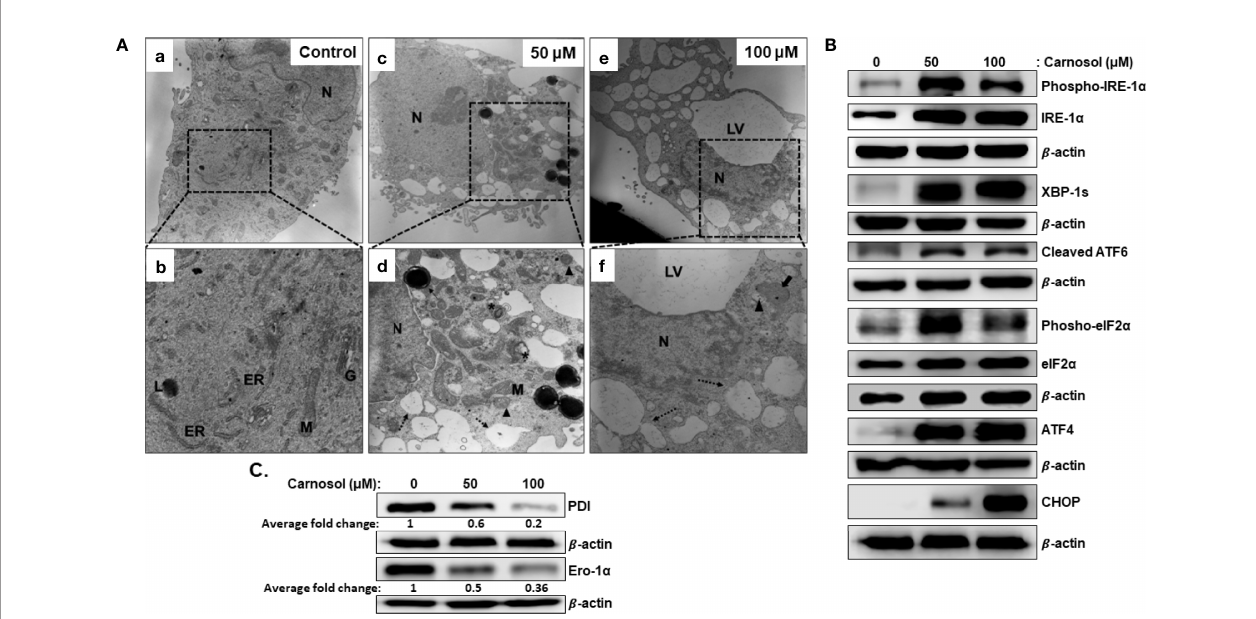
FIGURE 3 | Carnosol induces ER stress in MDA-MB-231 cells. (A) Representative electron micrographs of untreated MDA-MB-231 cells (a – b) and MDA-MB-231 cells treated with 50 (c – d) and 100 µM (e – f) carnosol for 24 h. (B) Activation of the UPR sensors in carnosol-treated cells. Cells were treated for 24 hours with carnosol (50 and 100 m M) and whole protein lysates were analyzed by Western blot for proteins of the ER stress markers. (C) Carnosol disrupts the proper protein folding machinery. Immunoblot of protein folding enzymes PDI and Ero-1 a . Protein extract was prepared as described in (B)